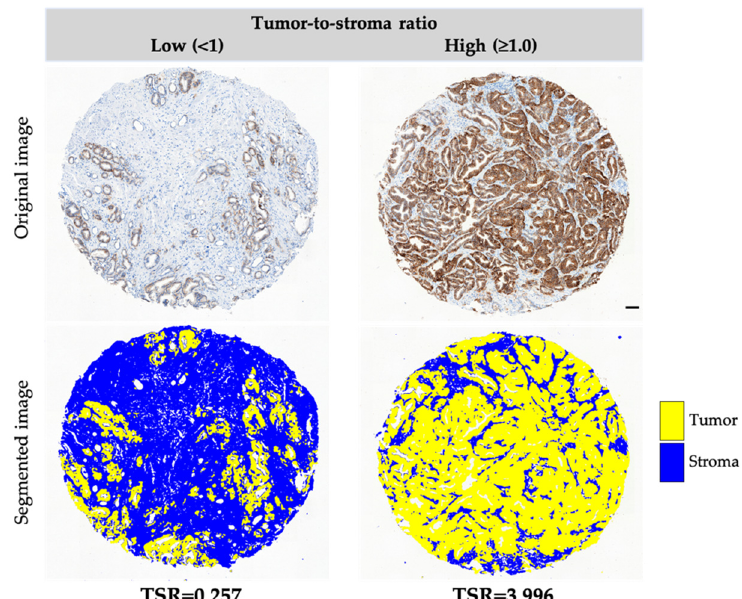
Figure 2. Representative photomicrographs of different TSR categories in prostate carcinomas: low and high. Tumor cells are stained with anti-EpCAM antibody and visualized in brown, whereas stroma is blue. Magnification 100×, scale bar corresponds to 100 µm.